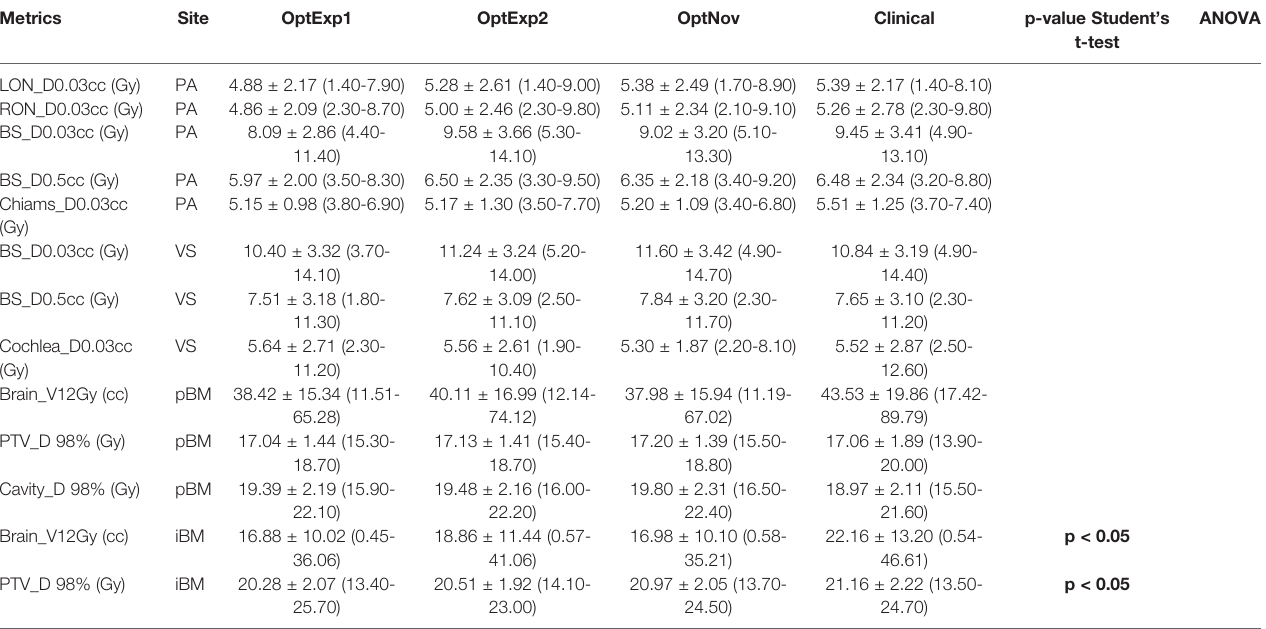
TABLE 2 | Summary of the dosimetric metrics among the inversely optimized and clinical plans for all sites.